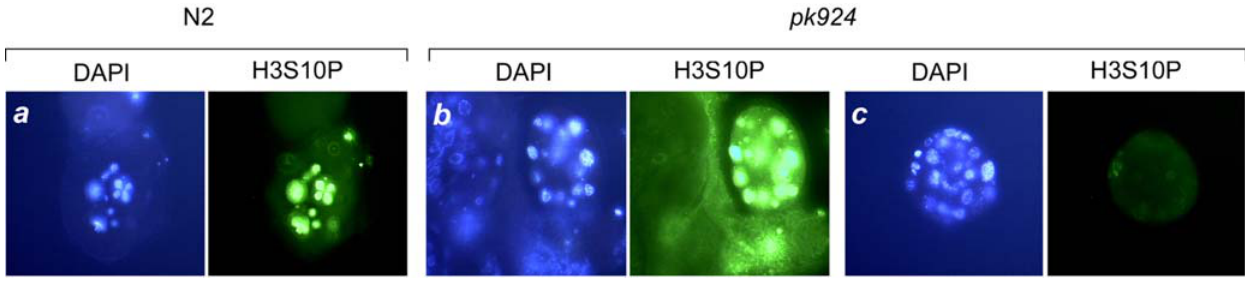
Figure 8. hcf-1pk924embryos display H3S10P deficiency upon protein phosphatase 1 RNAi treatment. H3S10P status in N2 (panel a ) and pk924 (panels b and c ) embryos upon RNAi of Ceglc-7 a and b . Embryos were stained with DAPI (blue) and anti H3S10P antisera